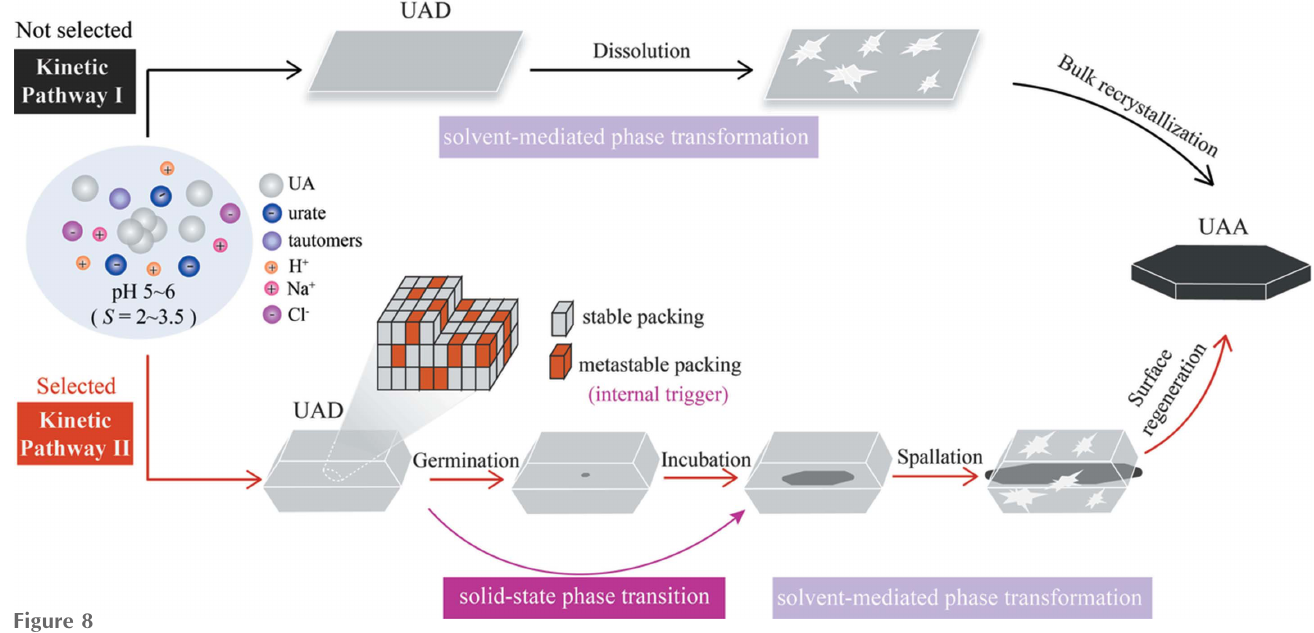
Figure 8 Proposed mechanism of the shape-preserved core-shell phase